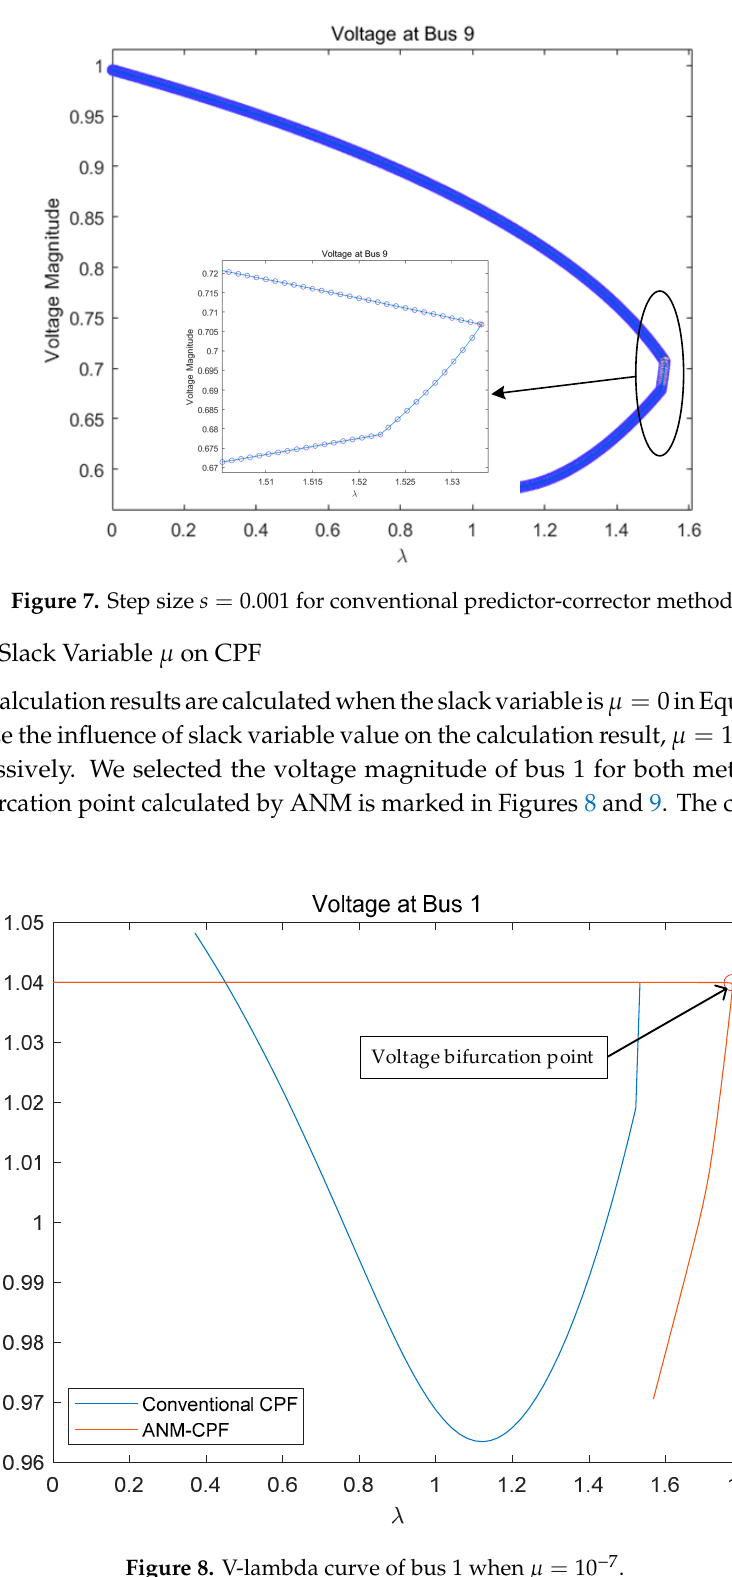
Figure 6. V-lambda curve of bus 9 for both methods.